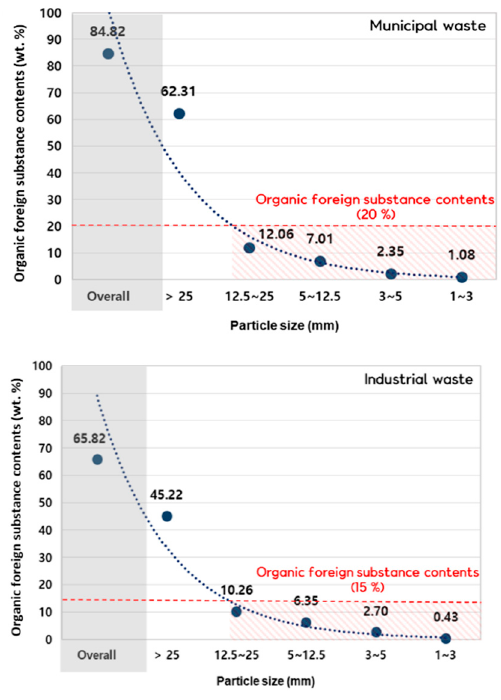
Figure 4. Organic foreign substance contents by particle size of residues.